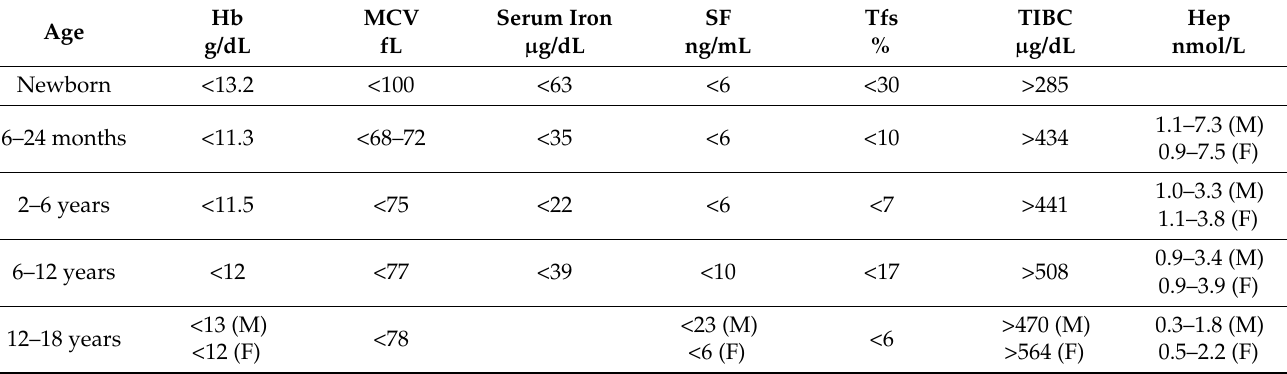
Table 2. Cutoff points according to age for hematometric iron